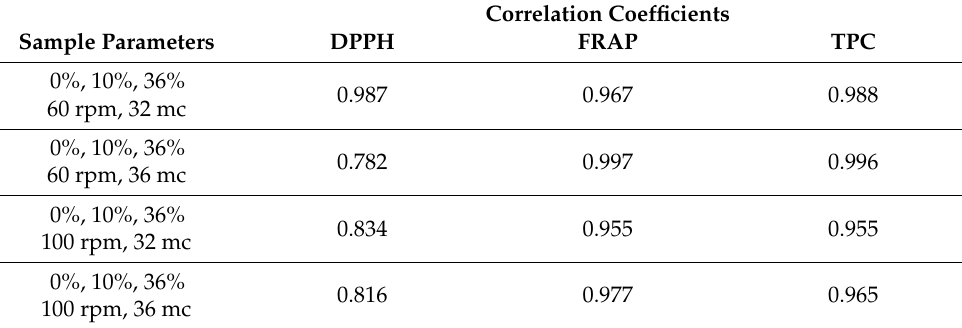
Table 4. Correlation coefficients for DPPH, FRAP, and TPC.